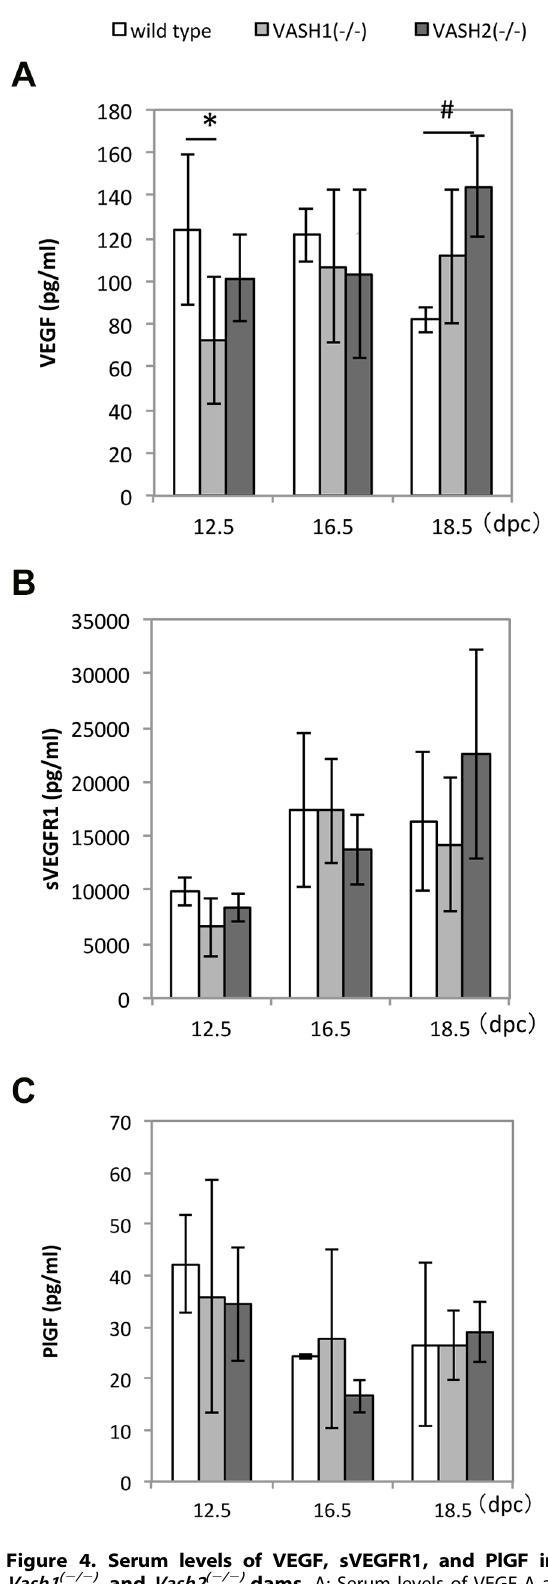
Figure 4. Serum levels of VEGF, sVEGFR1, and PlGF in WT, Vash1 ( 2 / 2 ) , and Vash2 ( 2 / 2 ) dams. A: Serum levels of VEGF-A at 12.5, 16.5, and 18.5 dpc. The respective numbers of WT dams at these time points were 6, 3 and 4; of Vash1 ( 2 / 2 ) ones, 7, 10 and 22; and of Vash2 ( 2 / 2 ) dams, 4, 4 and 8. # P , 0.05, *P , 0.01. B: Serum levels of sVEGFR1 at 12.5, 16.5, and 18.5 dpc. The respective numbers of WT dams at these